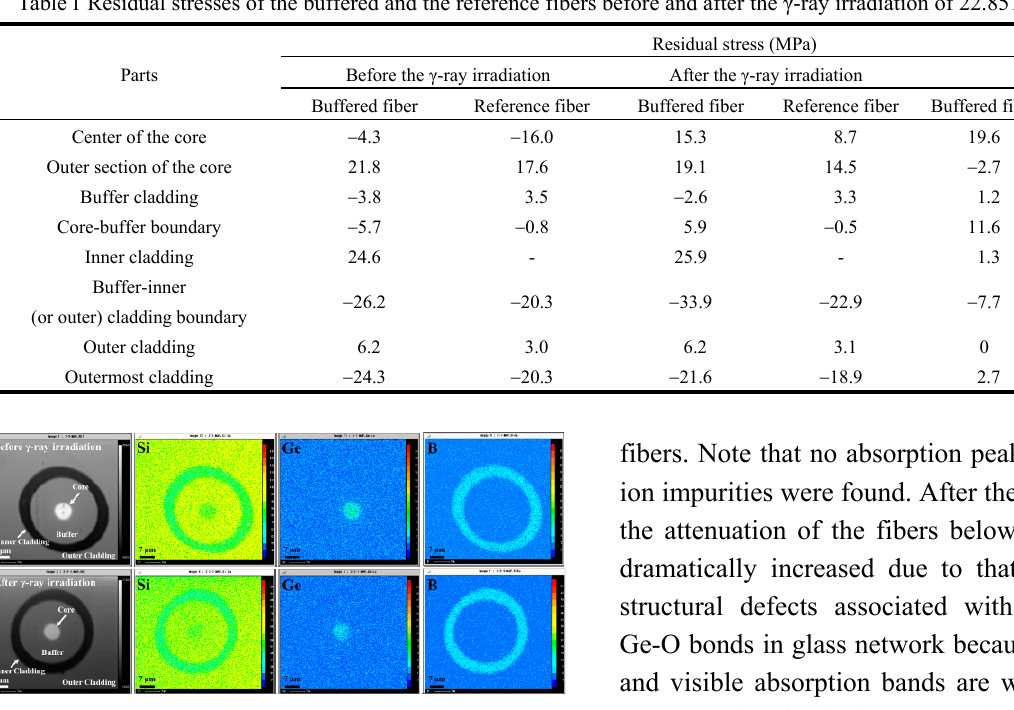
Fig. 4 EPMA based images with mapping analysis of different elements in the cross section of the buffered fiber before and after the γ -ray